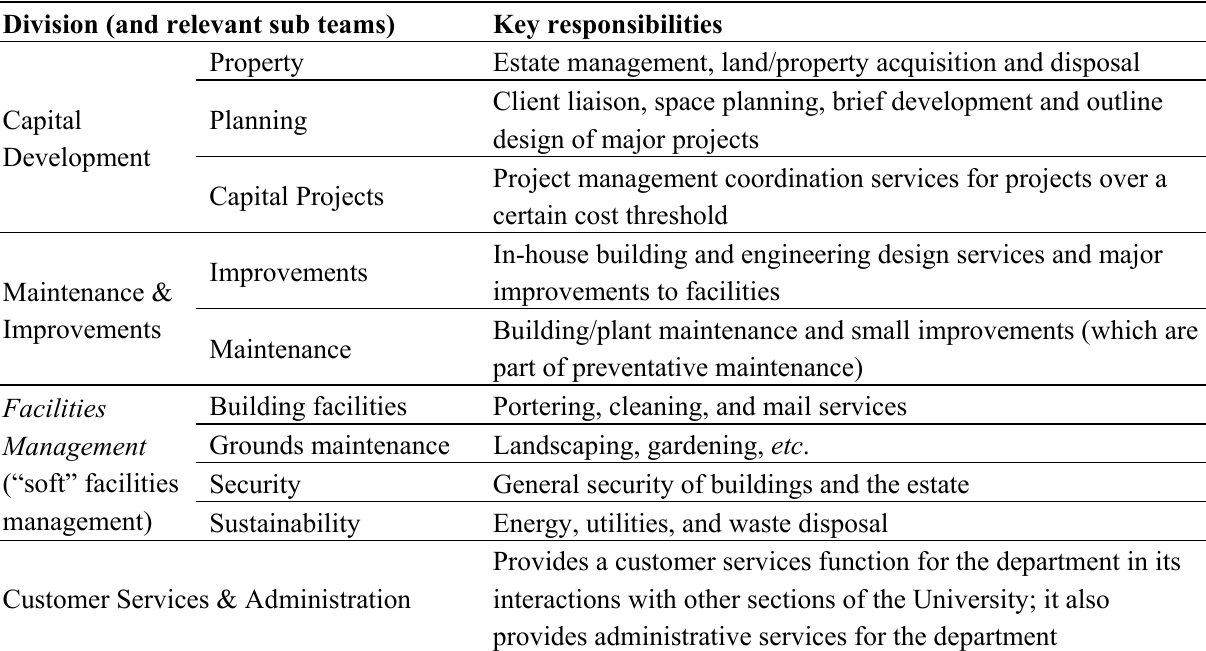
Table 3. Main Divisions and Responsibilities of the Estates